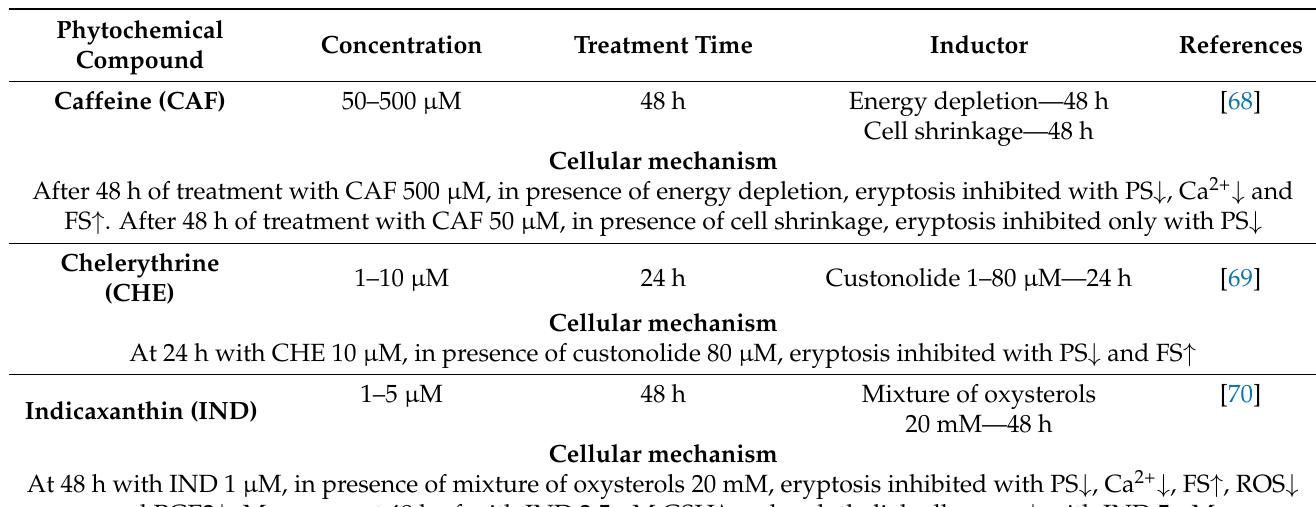
Table 2. Mechanisms involved in the anti-eryptotic effect of alkaloids compounds against different stimuli in human